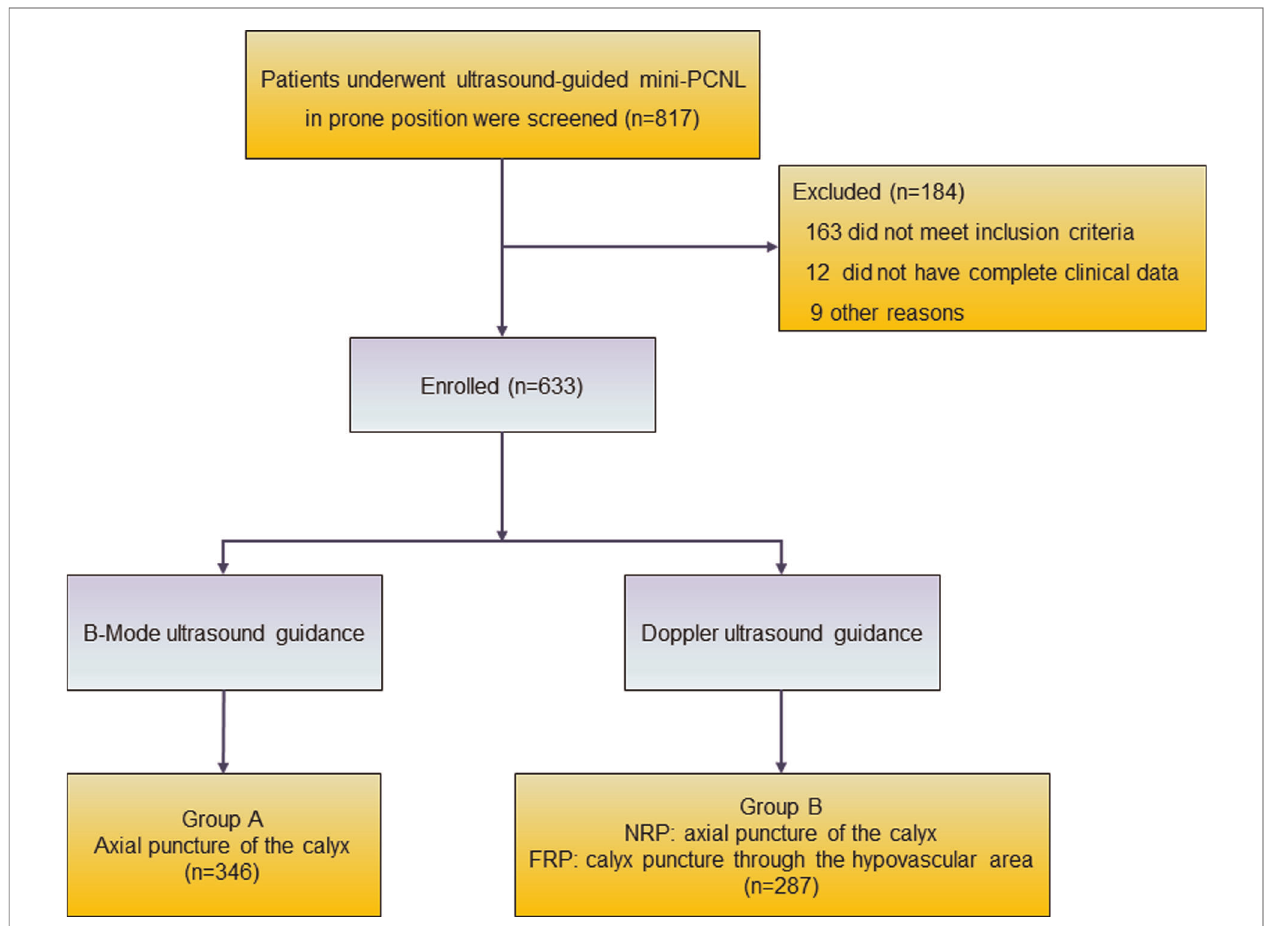
FIGURE 2 | Flow diagram of excluded and grouped patients. NRP, normal renal pyramid; FRP, fused renal